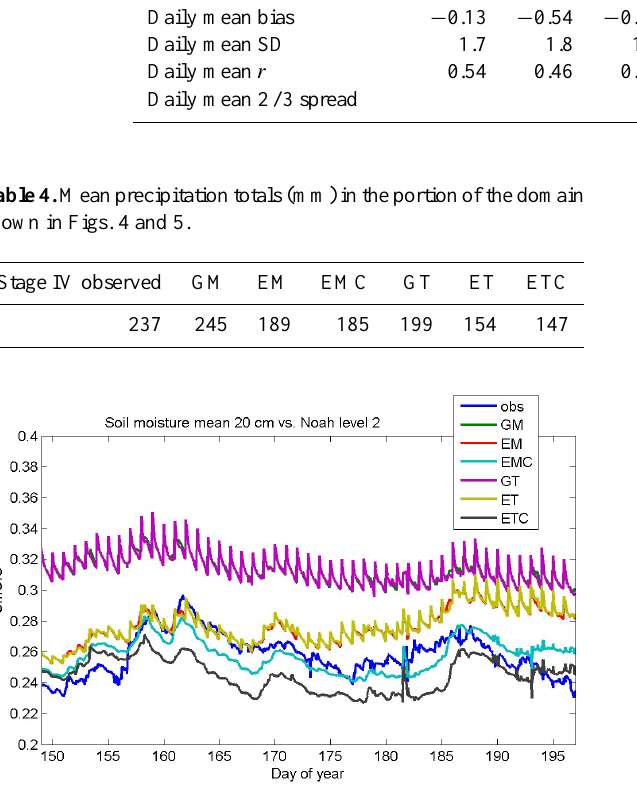
Figure 2. Soil moisture mean of 28 Climate Reference Network Figure 2: Soil moisture mean of 28 Climate Reference Network stations. Measurement at 20 cm 540 stations. Measurement at 20cm depth is compared to second model level (10–40cm). Legend refers to Table 1. Run GM is often ob- depth is compared to second model level (10-40 cm). Legend refers to table 1. Run GM is often 541 scured by GT. obscured by GT. 542